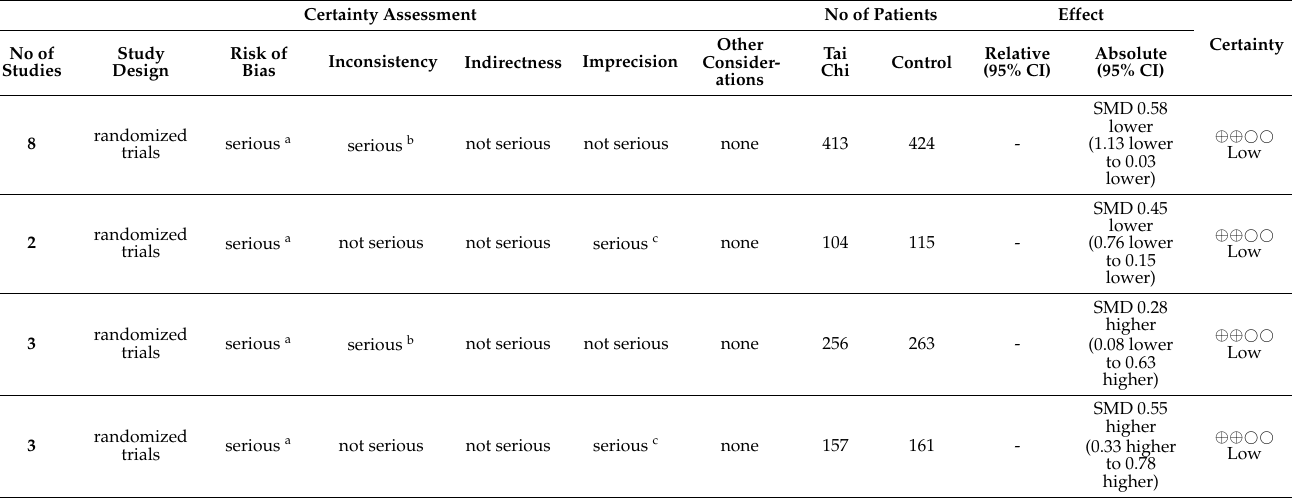
Table 2. Summary of the findings of the GRADE quality assessment for a comparison of combinations Tai Chi and antidepressants versus standard antidepressants.